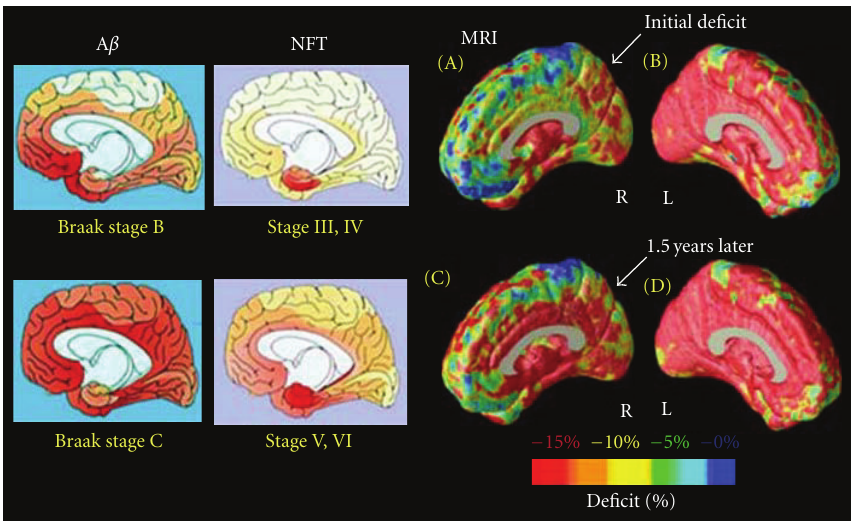
Figure 10: Gray matter deficits spread through the limbic system in moderate AD. Average maps of gray matter density in patients and controls were subtracted at their first scan (A and B) and at their followup scan 1.5 years later (C and D). Colors show the average percentage loss of gray matter relative to the control average. Profound loss engulfs the left medial wall ( > 15%; B and D). On the right, however, the deficits in temporoparietal and entorhinal territory (A) spread forward into the cingulate gyrus 1.5 years later (C). Limbic and frontal zones clearly show di ff erent degrees of impairment (C). MRI-based changes, in living patients, agree strongly with the spatial progression of β -amyloid (A β ) and NFT pathology observed after mortem (Braak Stages B, C, and III to VI), (adapted with permission from [37, 38]).